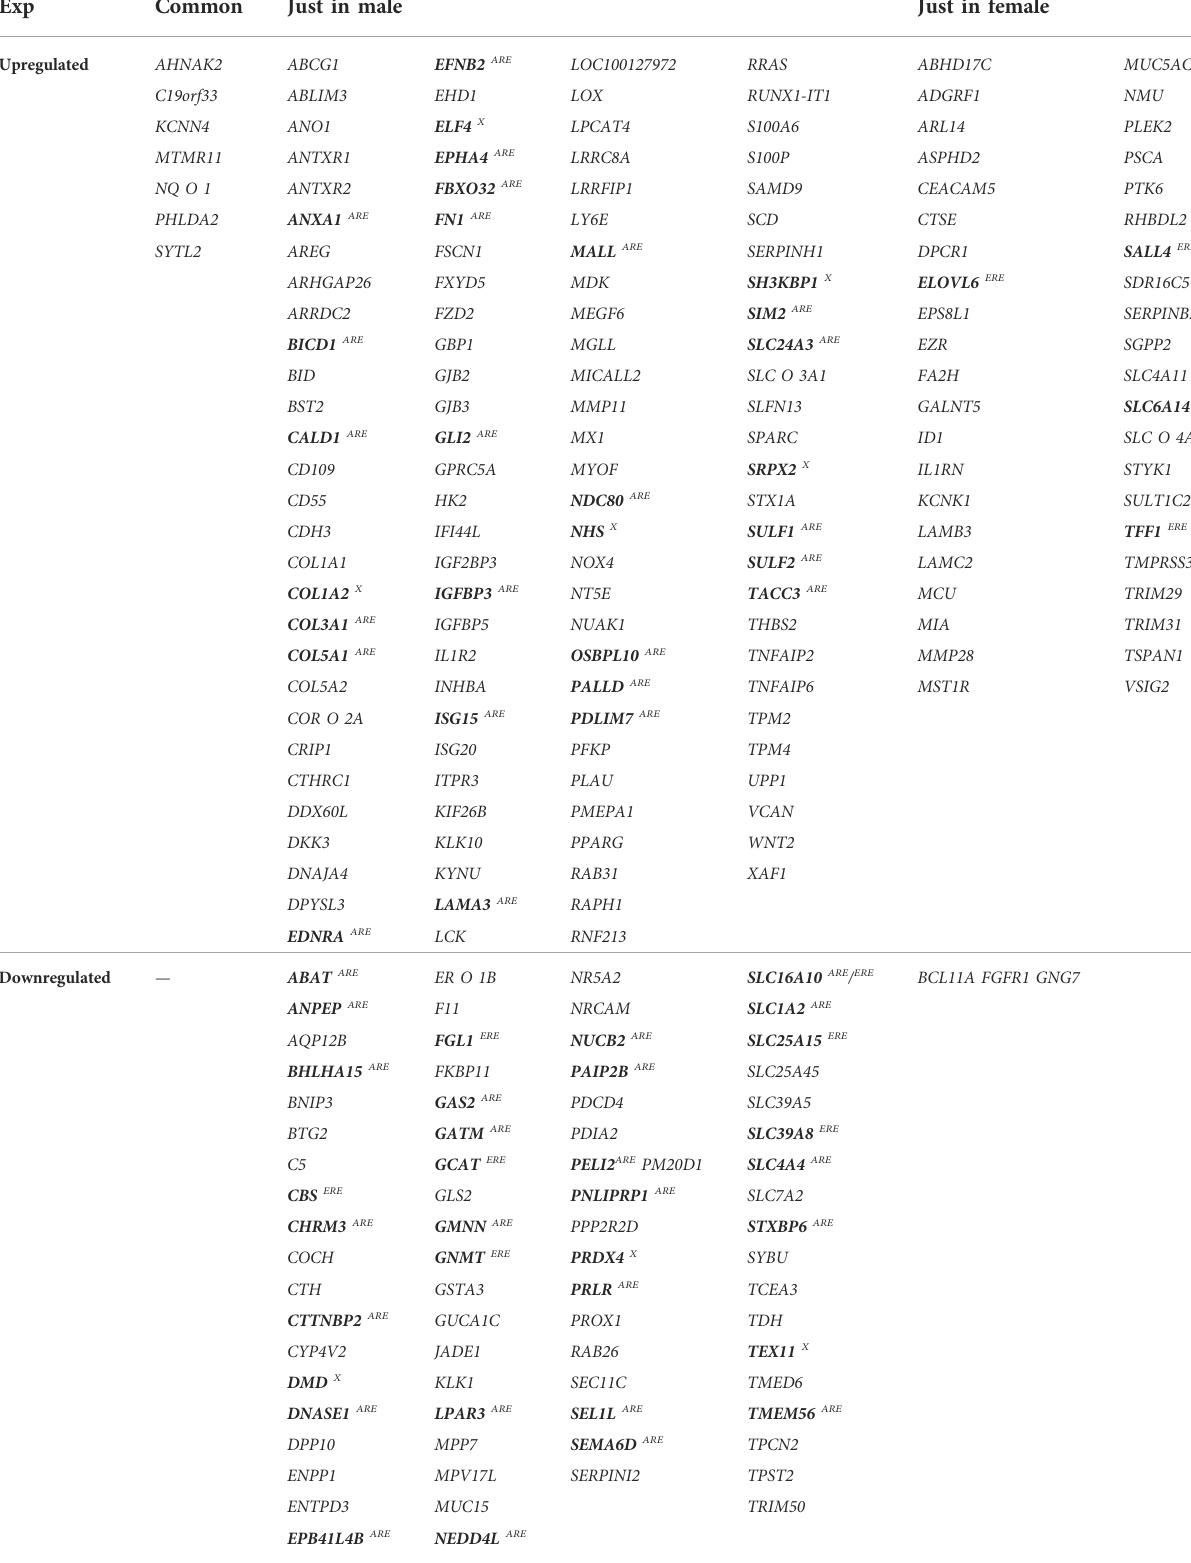
TABLE 2 List of common genes between all studies for each gender and both (genes which may be affected by gender are speci fi ed in bold, and GLI2 targets have been underlined). Exp Common Just in male Just in female